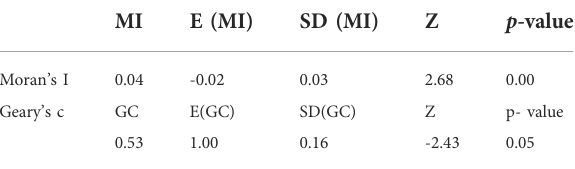
TABLE 3 Spatial autocorrelation of CO 2